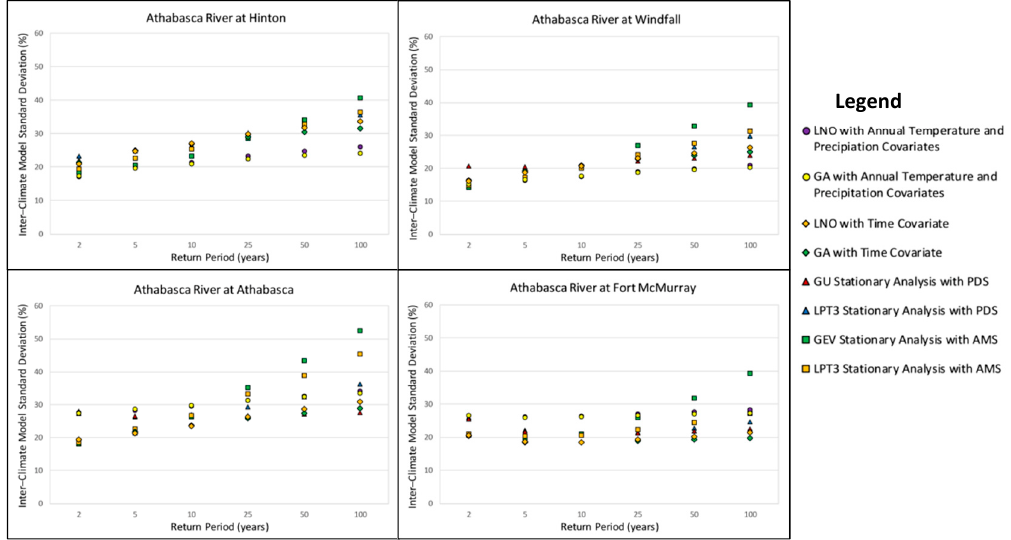
Figure 10. Inter- climate model variability of projected changes in peak flow between the 2080s and the 1990s baseline period for the RCP8.5 emissions scenario corresponding to each of the statistical methods considered.